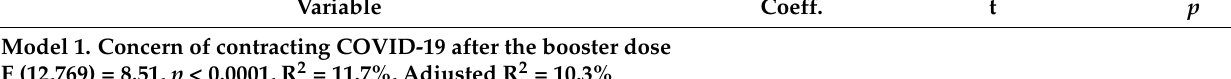
Table 2. Predictors of the first two outcomes of interest using multivariate linear regression analysis. Variable